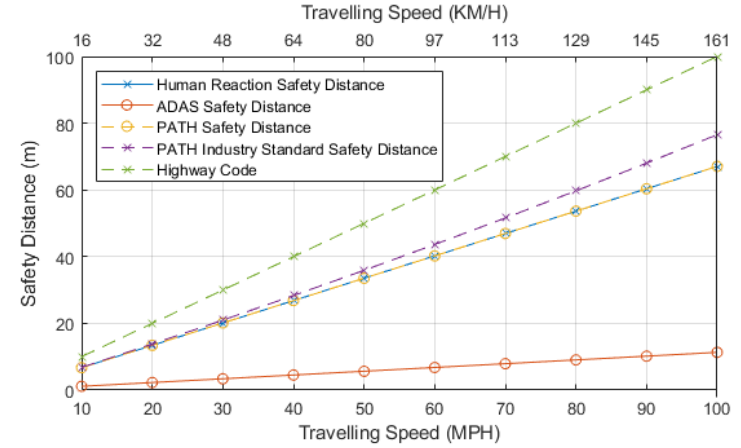
Figure 12. Safety distance